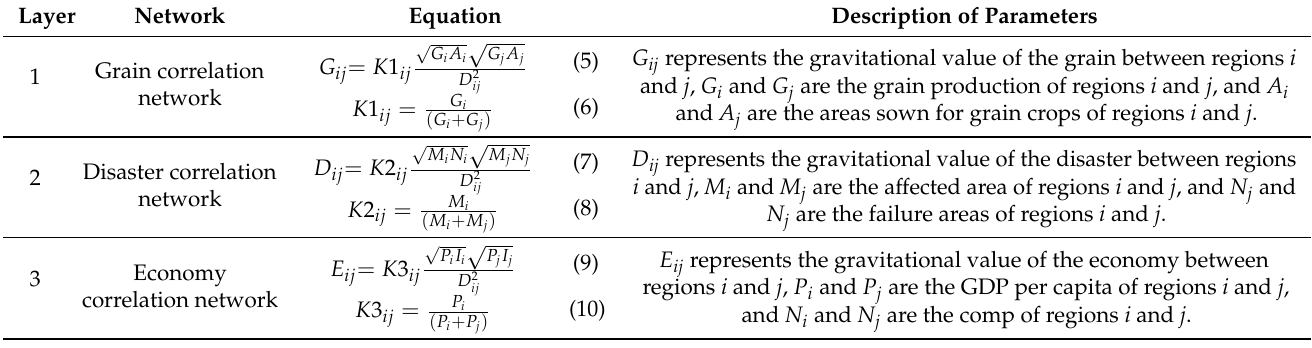
Table 3. Explanation of equation measurement for single-layer network.